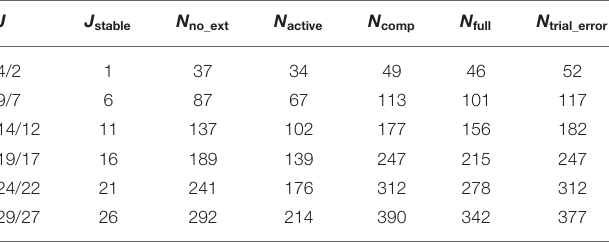
TABLE 2 | Number of rollouts required to converge to a success rate of at least 90% for different numbers of additional behaviors J stable